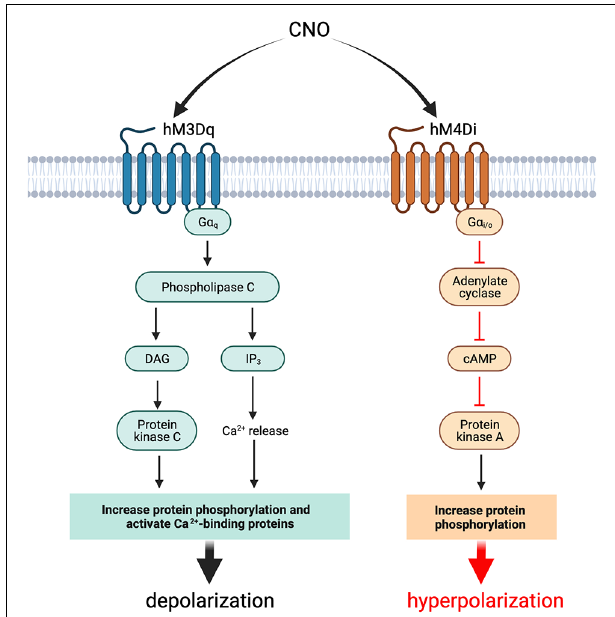
FIGURE 1 | Effects of activation of hM3Dq and hM4Di with CNO in neurons and interneurons. Activation of the DREADD probe hM3Dq with CNO in neurons and interneurons results in cellular depolarization while activation of hM4Di results in hyperpolarization. The net effect of activation of the DREADD construct is dependent on whether inhibitory or excitatory chemogenetics are used and which cell populations are targeted. cAMP, cyclic adenosine monophosphate; CNO, clozapine-N-oxide; DAG, diacylglycerol; DREADDs, designer receptors exclusively activated by designer drugs; hM3Dq, G q -coupled human M3 muscarinic DREADD; hM4Di, G i -coupled human M4 muscarinic DREADD; IP 3 , inositol